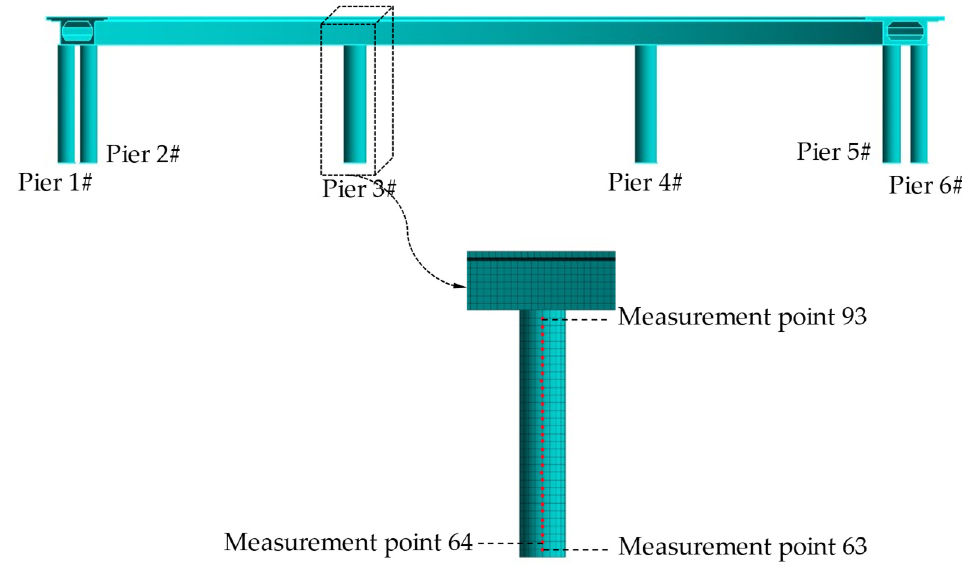
Figure 5. Layout of measurement points.